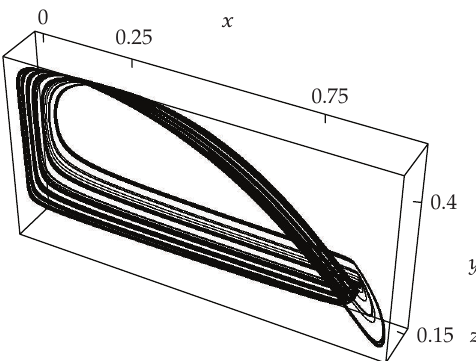
Figure 1: Solution visualized as a trajectory in the three-dimensional space for (cid:3) (cid:7) 0 . 4 and δ 2 (cid:7) 0 . 65.